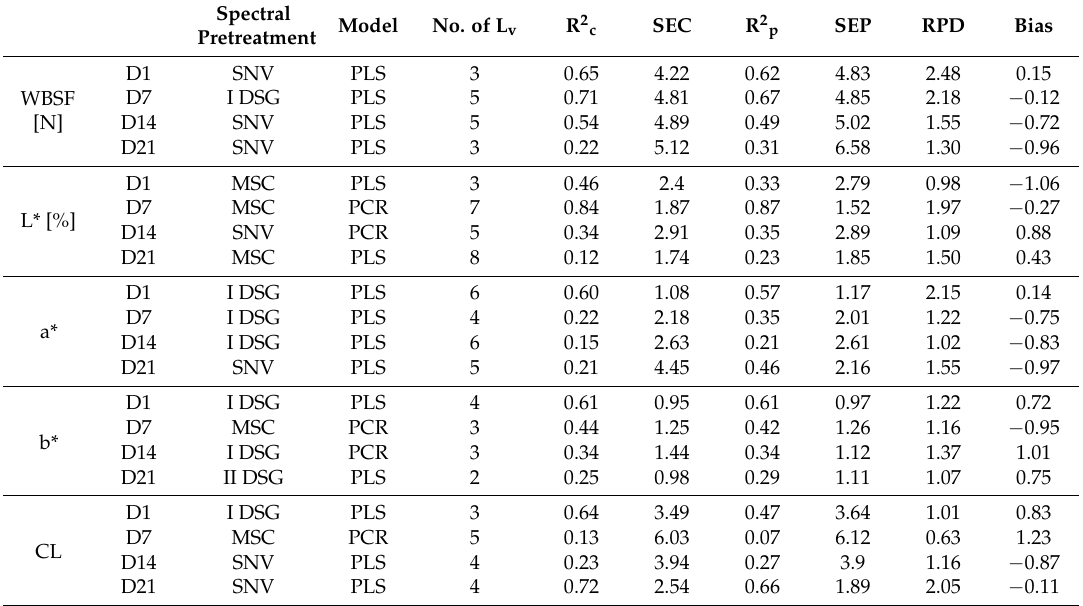
Table 3. NIRS calibration and prediction statistics for WBSF, color ( L *, a *, b *) and CL of LL muscle. Spectral Pretreatment